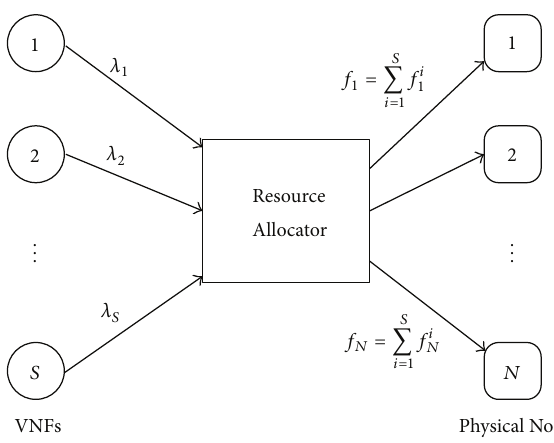
Figure 1: System model for VNFs resource